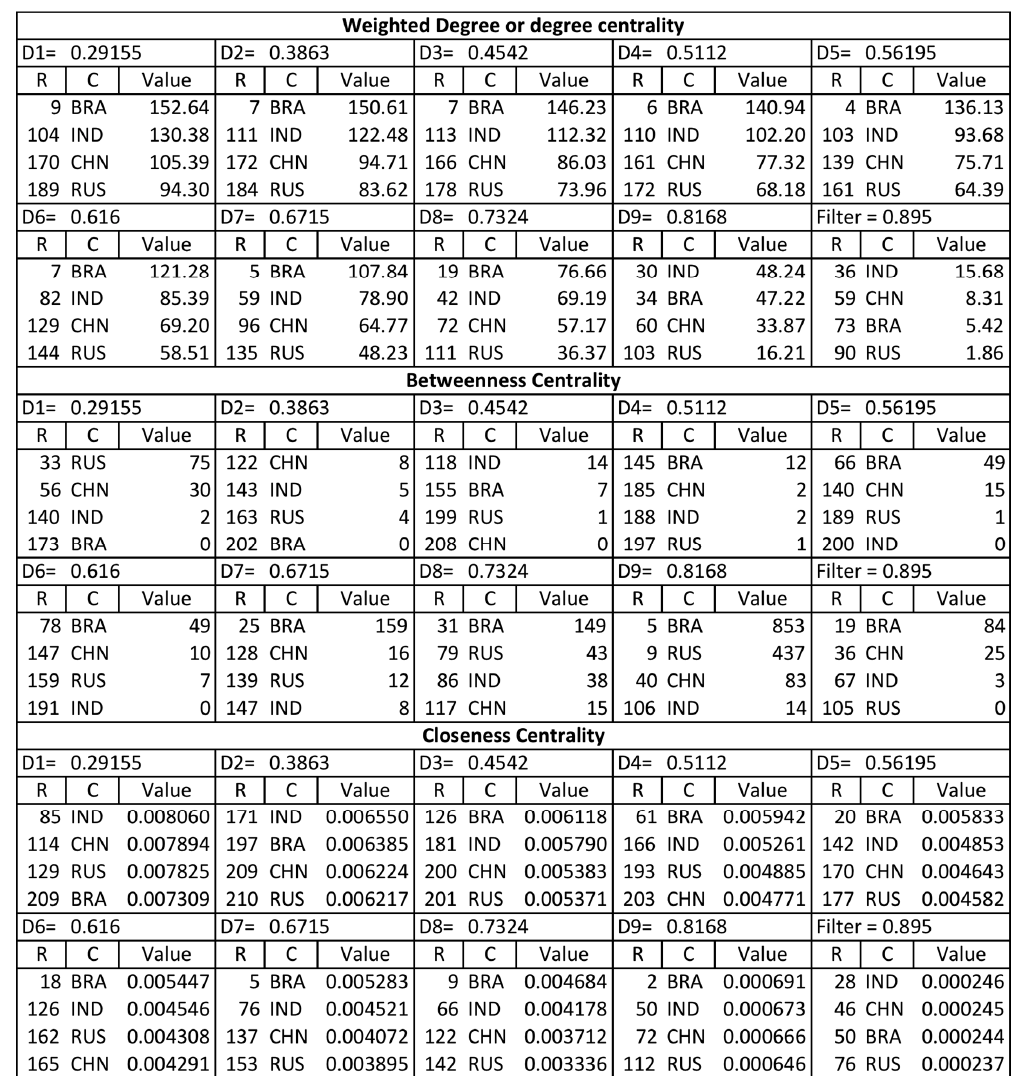
Table 1. R = Ranking, C =